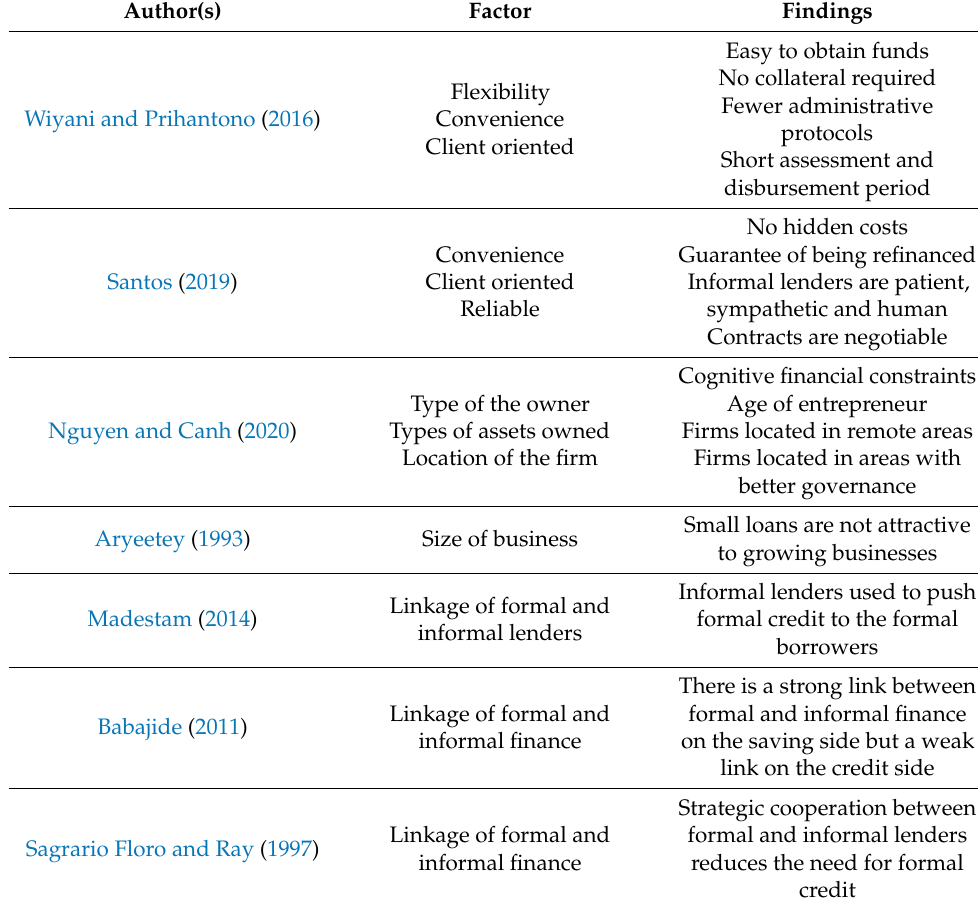
Table 3. Factors that influence the use of informal finance by